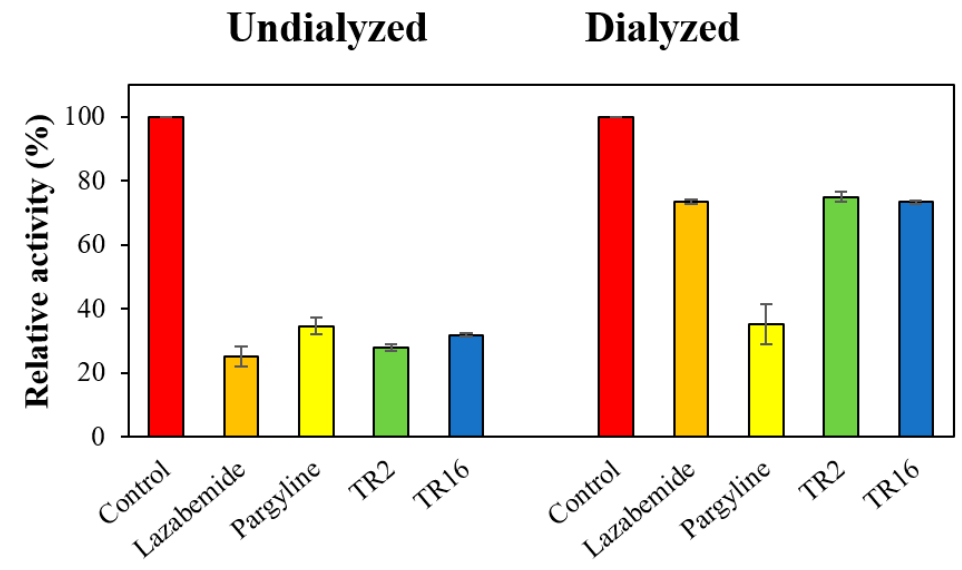
Figure 2. Recoveries of MAO-B inhibitions by TR2 and TR16 using dialysis experiments.